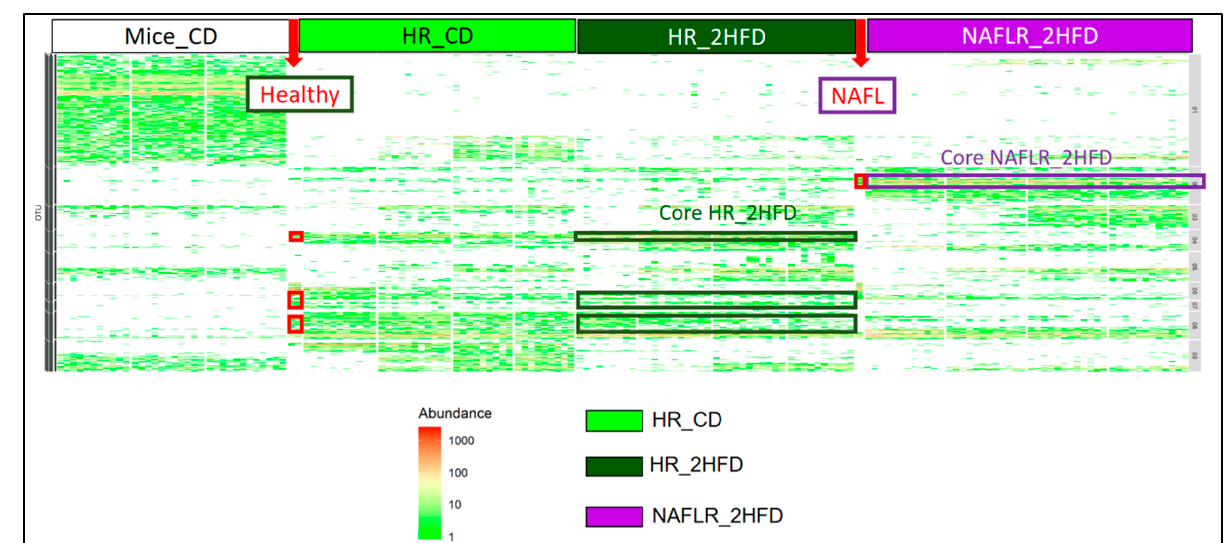
Figure 10. Heatmap characterization of differentially abundant and prevalent operational taxonomic units (OTUs) all throughout the experiment. CD, control diet; 2HFD, high-fructose, high-fat diet; Mice_CD, mice microbiota at basal state, day 6, on CD; Healthy, healthy human microbiota; NAFL, NAFL patient microbiota; HR, healthy human microbiota receiver mice; NAFLR, NAFL patient microbiota receiver mice; HR_CD, HR on CD regimen; HR_2HFD, HR on 2HFD regimen; NAFLR_2HFD, NAFLR on 2HFD regimen.